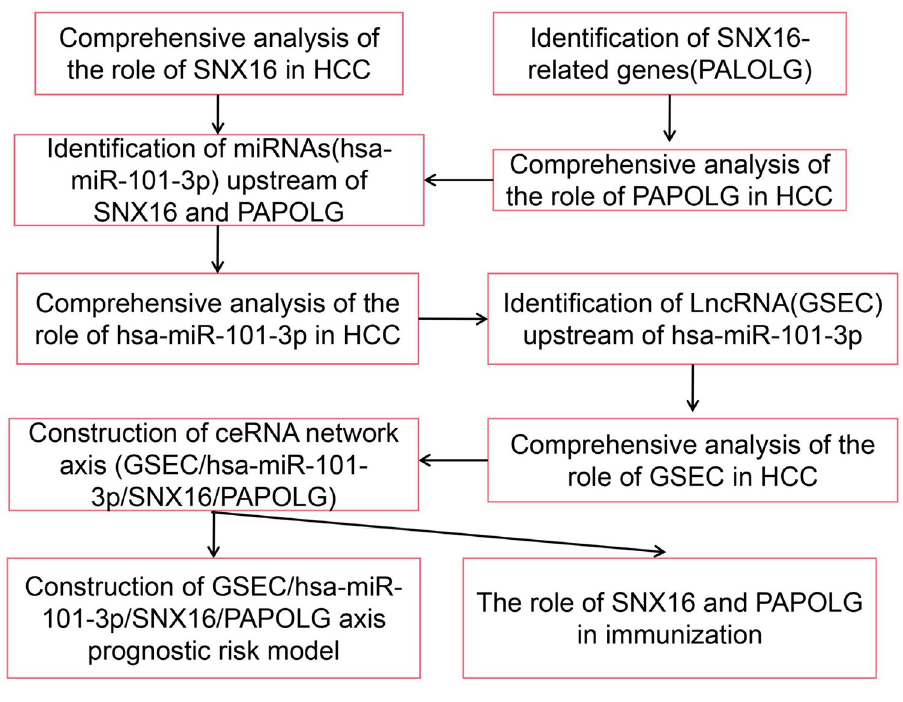
Fig 1. Flow chart of the analysis of this